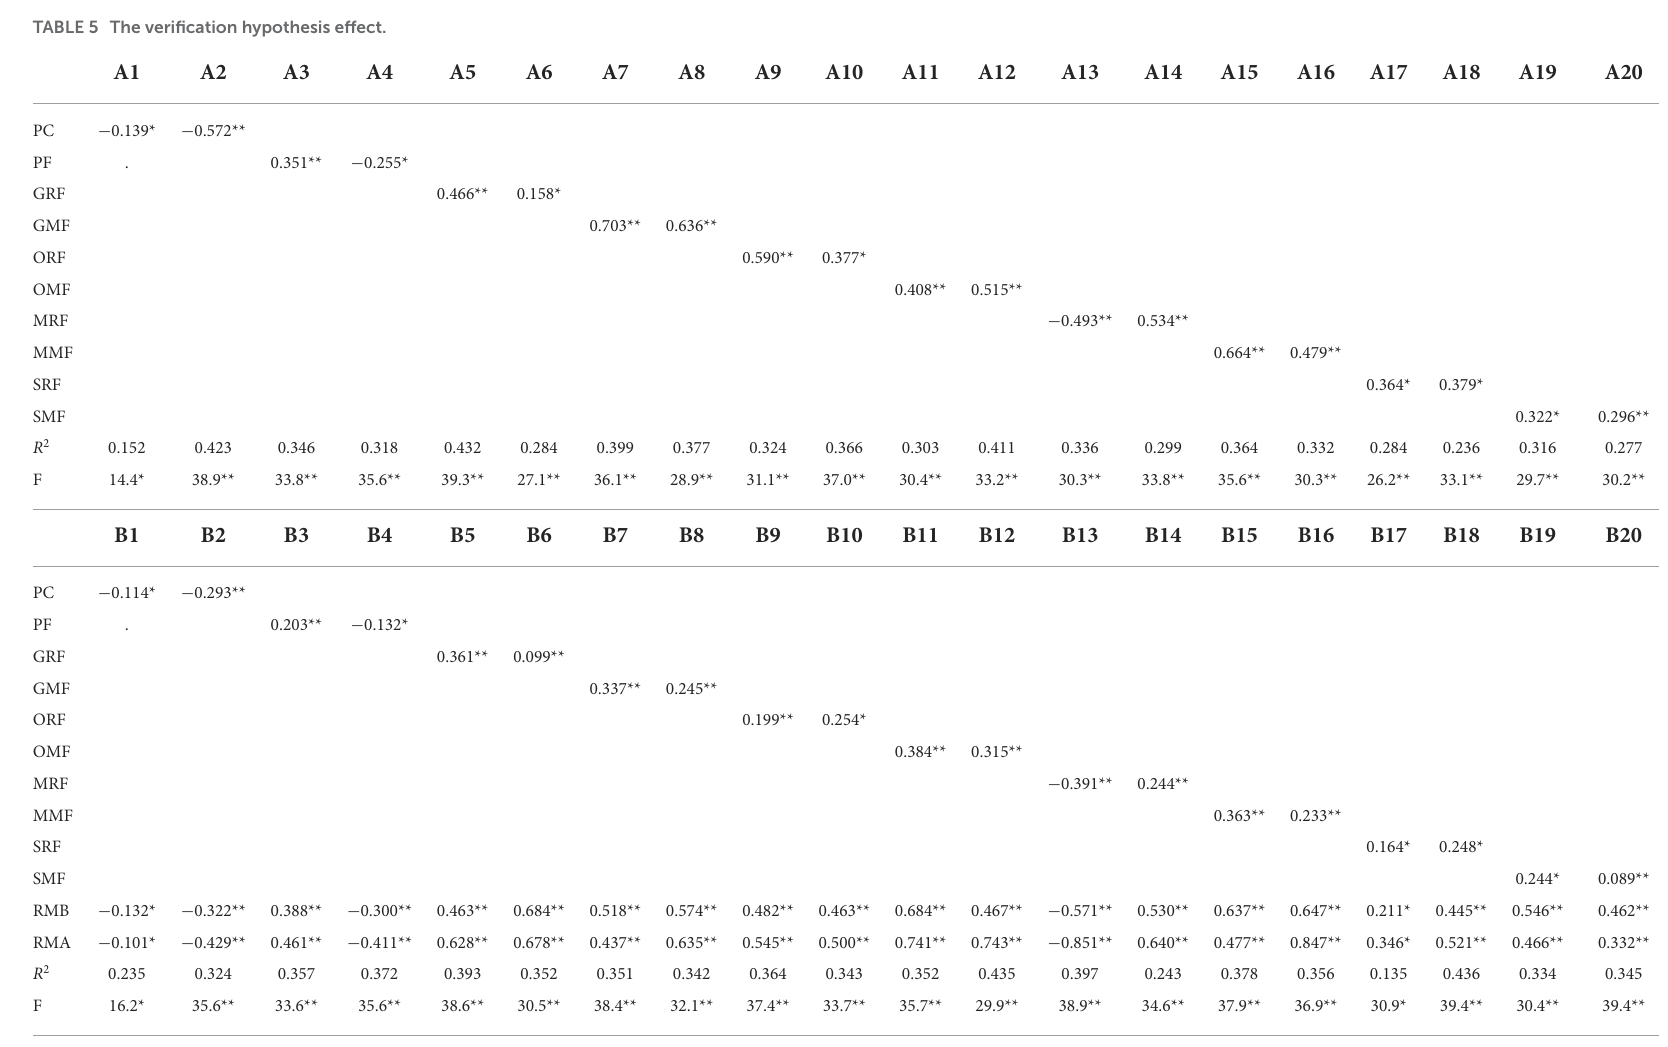
TABLE 5 The verification hypothesis